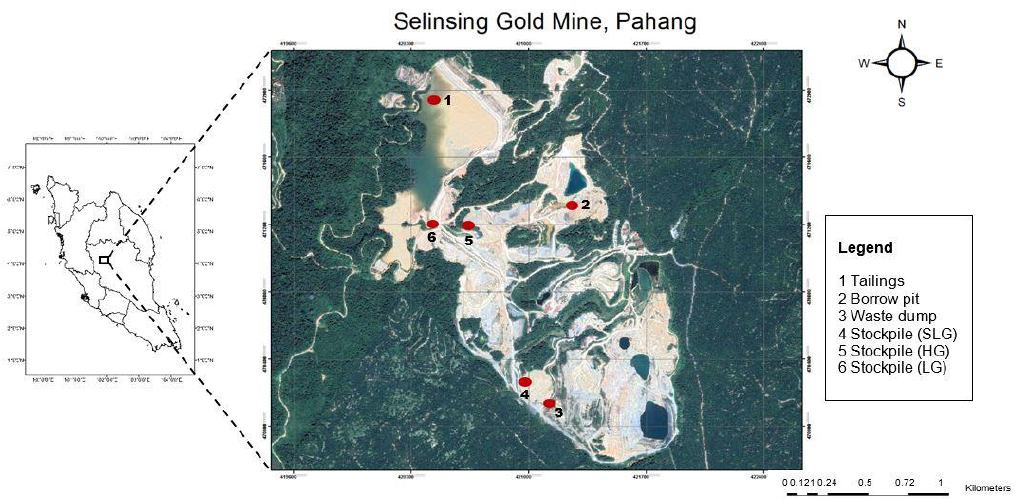
Figure 1. Locations of six sampling points at Selinsing Gold Mine, Pahang, Malaysia using geographic information system (GIS).